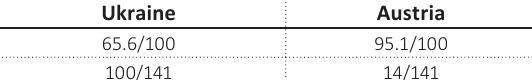
Table 4. The assessment of life expectancy in Ukraine and Austria in 2019